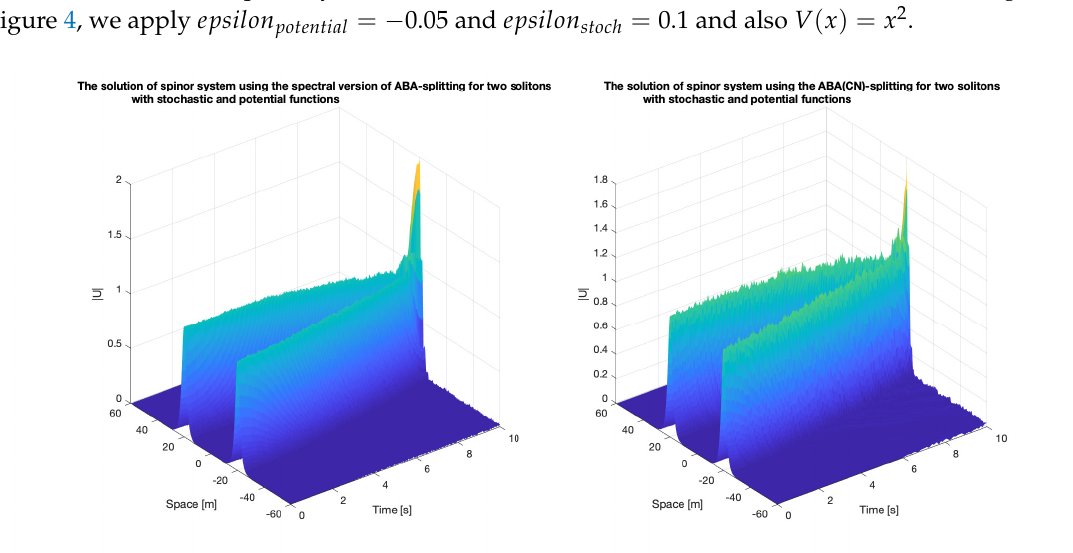
Figure 4. Solution of the spinor system with two solitons with the stochastic and potential functions (left-hand figure: the results with the time-splitting method; right-hand figure: the results with the ABA-iCN